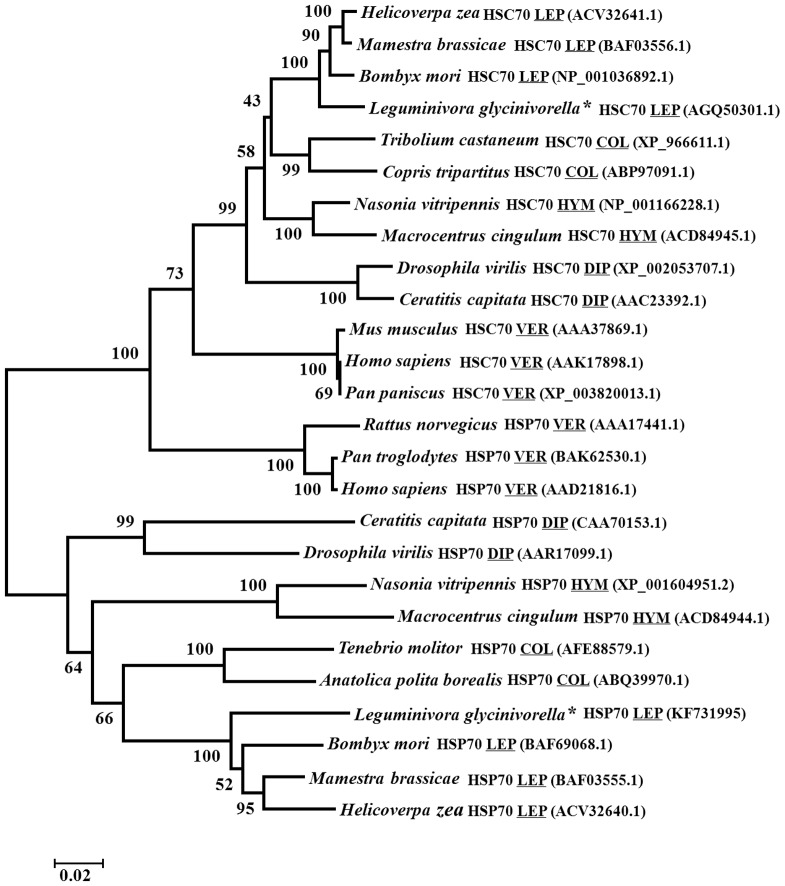
Phylogenetic tree of the HSP70 and HSC70 sequences, constructed using the neighbor-joining method.A three-letter code has been included to indicate the order name of the corresponding insects and vertebrates (COL =  Coleoptera, LEP =  Lepidoptera, DIP =  Diptera, HYM =  Hymenoptera and VER =  Vertebra). The values indicated on the branches correspond to bootstrap percentages (BP).